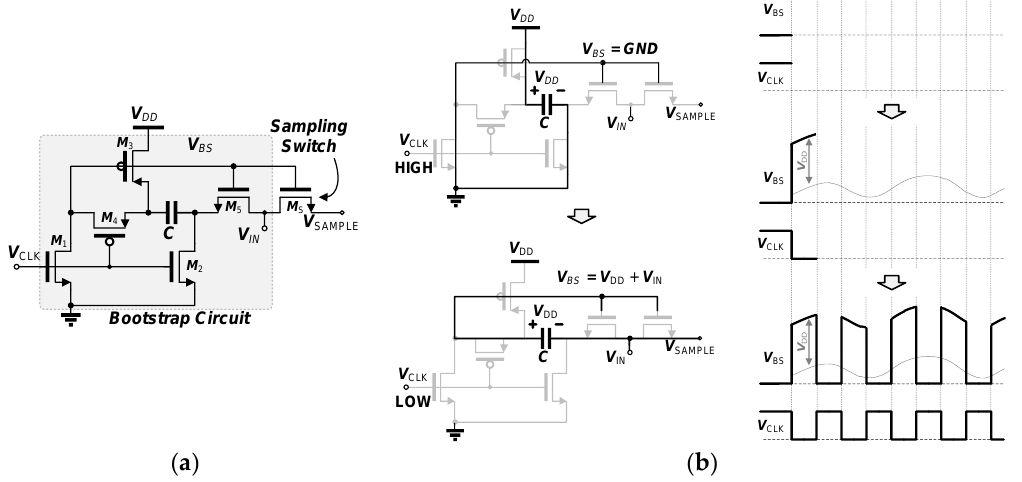
Figure 7. Low-power voltage-scalable single-clock (LVS) bootstrap circuit: ( a ) two-stage bootstrap circuit and ( b ) its operation and output.